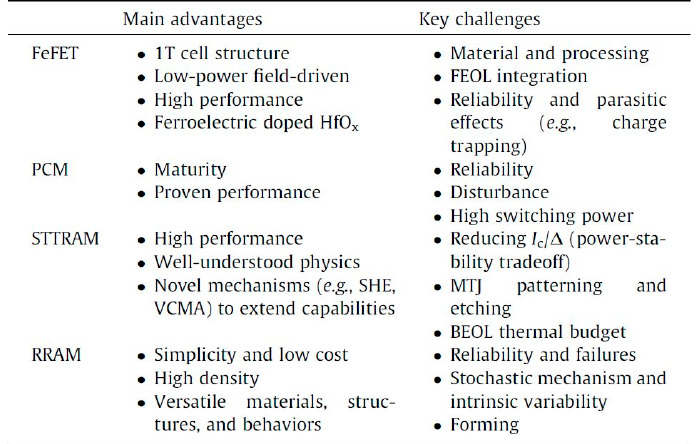
Figure 12. Advantages and challenges of the main emerging NVM technologies. (Reproduced from Solid-State Electron. 2016, 125, 25–38, with the permission of Elsevier Publishing [2].)